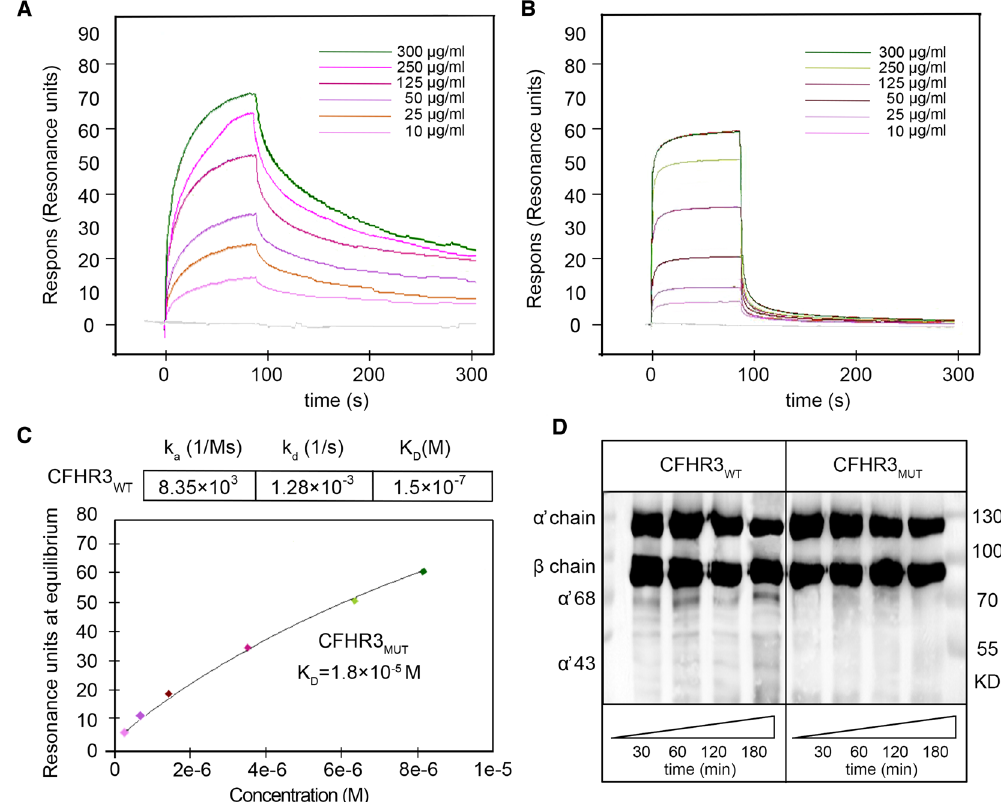
Figure 4. The CFHR3 T risk allele of rs61737525 results decreased binding affinity to C3b and a weaker fluid-phase cofactor activity. C3b was immobilized to a CM5 chip using standard amine coupling. Duplicate injections of CFHR3 WT and CFHR3 Arg142Cys were performed (concentrations of 10–300 ug/ml) in 10 mM Hepes-buffered saline with 3 mM ENTA and 0.05% (vol/vol) surfactant p20. Overlaid sensograms of binding of ( A ) CFHR3 WT and ( B ) CFHR3 Arg142Cys to C3b, showing a kinetic and steady-state response, respectively. ( C ) The CFHR3 Arg142Cys exhibits a binding to C3b (K D = 1.8 × 10 − 5 M; R max = 194.4RU; chi-squared = 0.47), which was lower than that of CFHR3 WT (K D = 1.5 × 10 − 7 M; R max = 37.2RU; chi-squared = 8.81). ( D ) Limiting concentrations (700 ug/ml) of CFHR3 WT and CFHR3 Arg142Cys were incubated with factor I and the substrate C3b with increasing time points. Subsequently, the loss of the intact C3b α ’-chain and appearance of its factor I cleavage products (43-kDa and 68-kDa fragments) were run on Western blot and visualized. It is apparent that mutant (Arg142Cys) CFHR3 blocks production of cleavage fragments compared to the wild-type